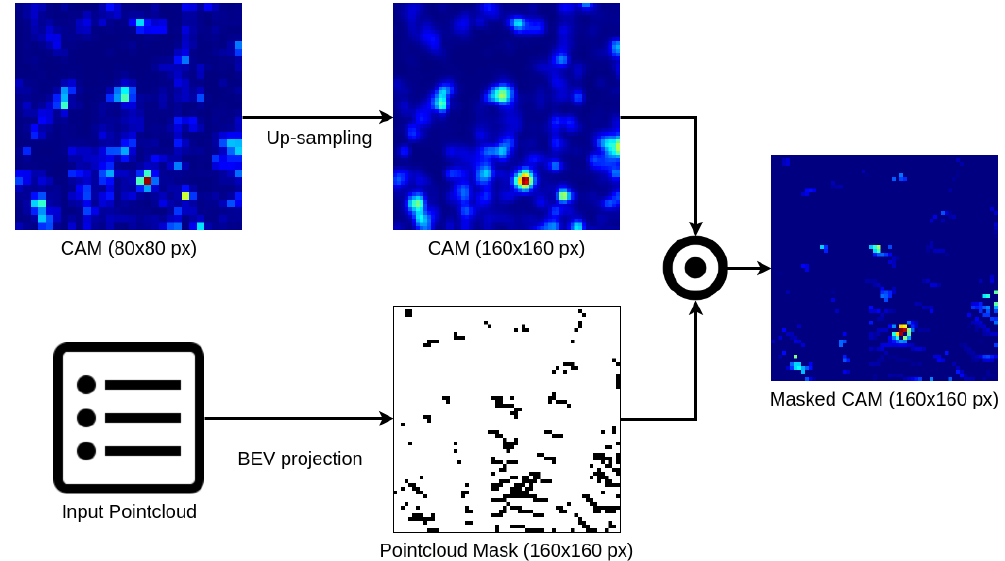
Figure 5. Masking CAMs with input pointcloud data is performed by casting LiDAR detections onto a dense BEV grid and multiplying the mask with an up-sampled CAM. The operation results in a high resolution heatmap with meaningful values only near actual